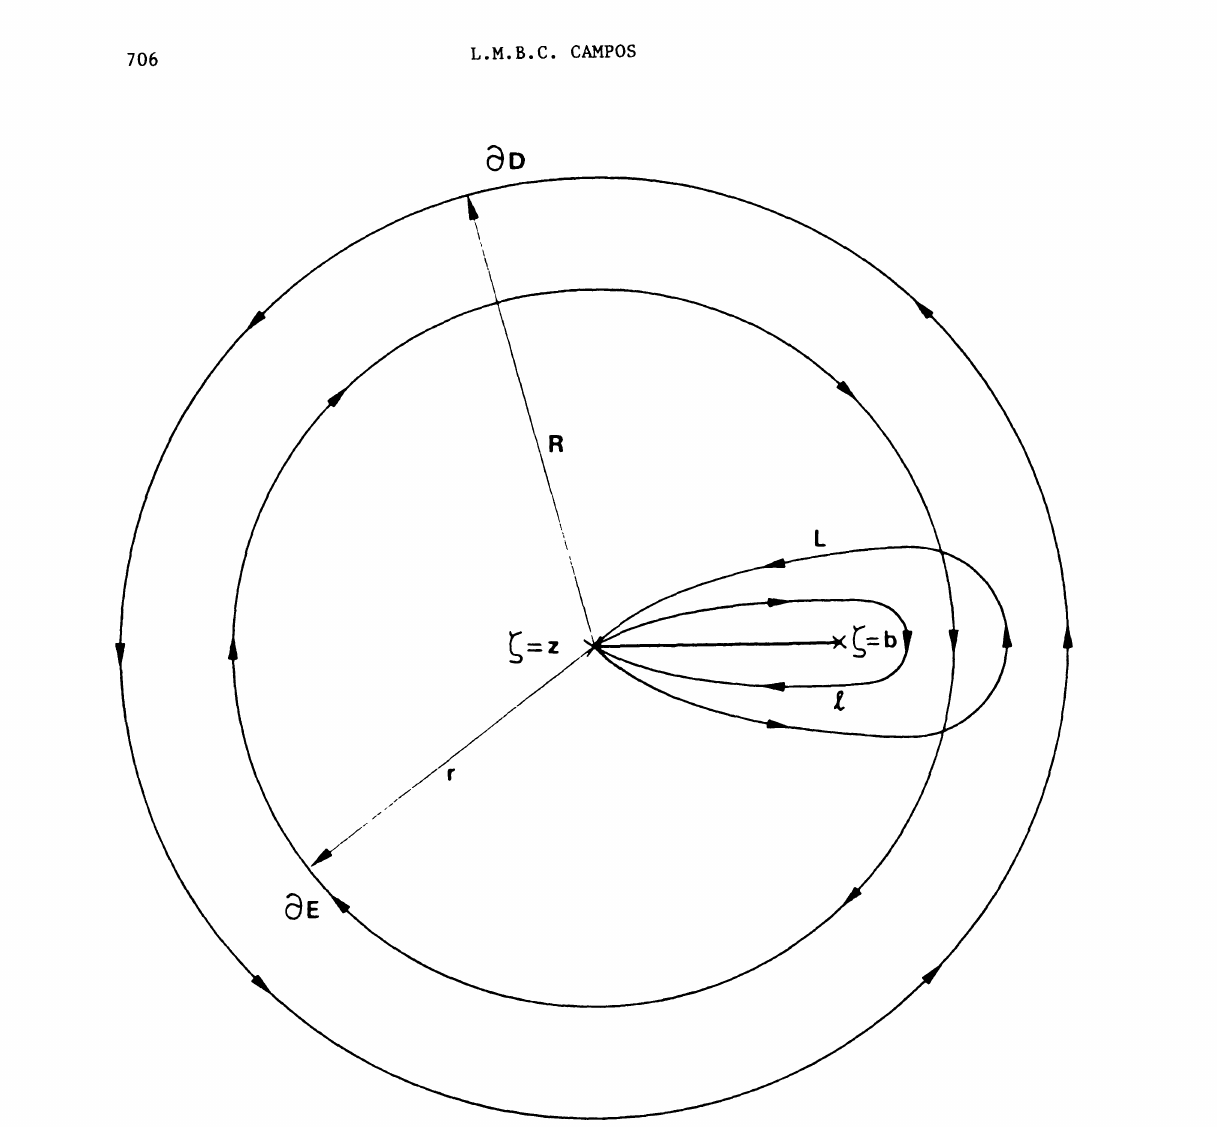
Figure 4- The ’Riemann’ differintegration of a function with an isolated outer =z, =a, L and a branch-point at involves an inner and an singularity at =z to =b, which teardrop loop, both about the same finite branch-cut joining can be deformed continuously, respectively onto the inner DE and outer D boundary, of the region of convergence of the generalized Teixeira (Laurent) series, whose boundary is a closed loop